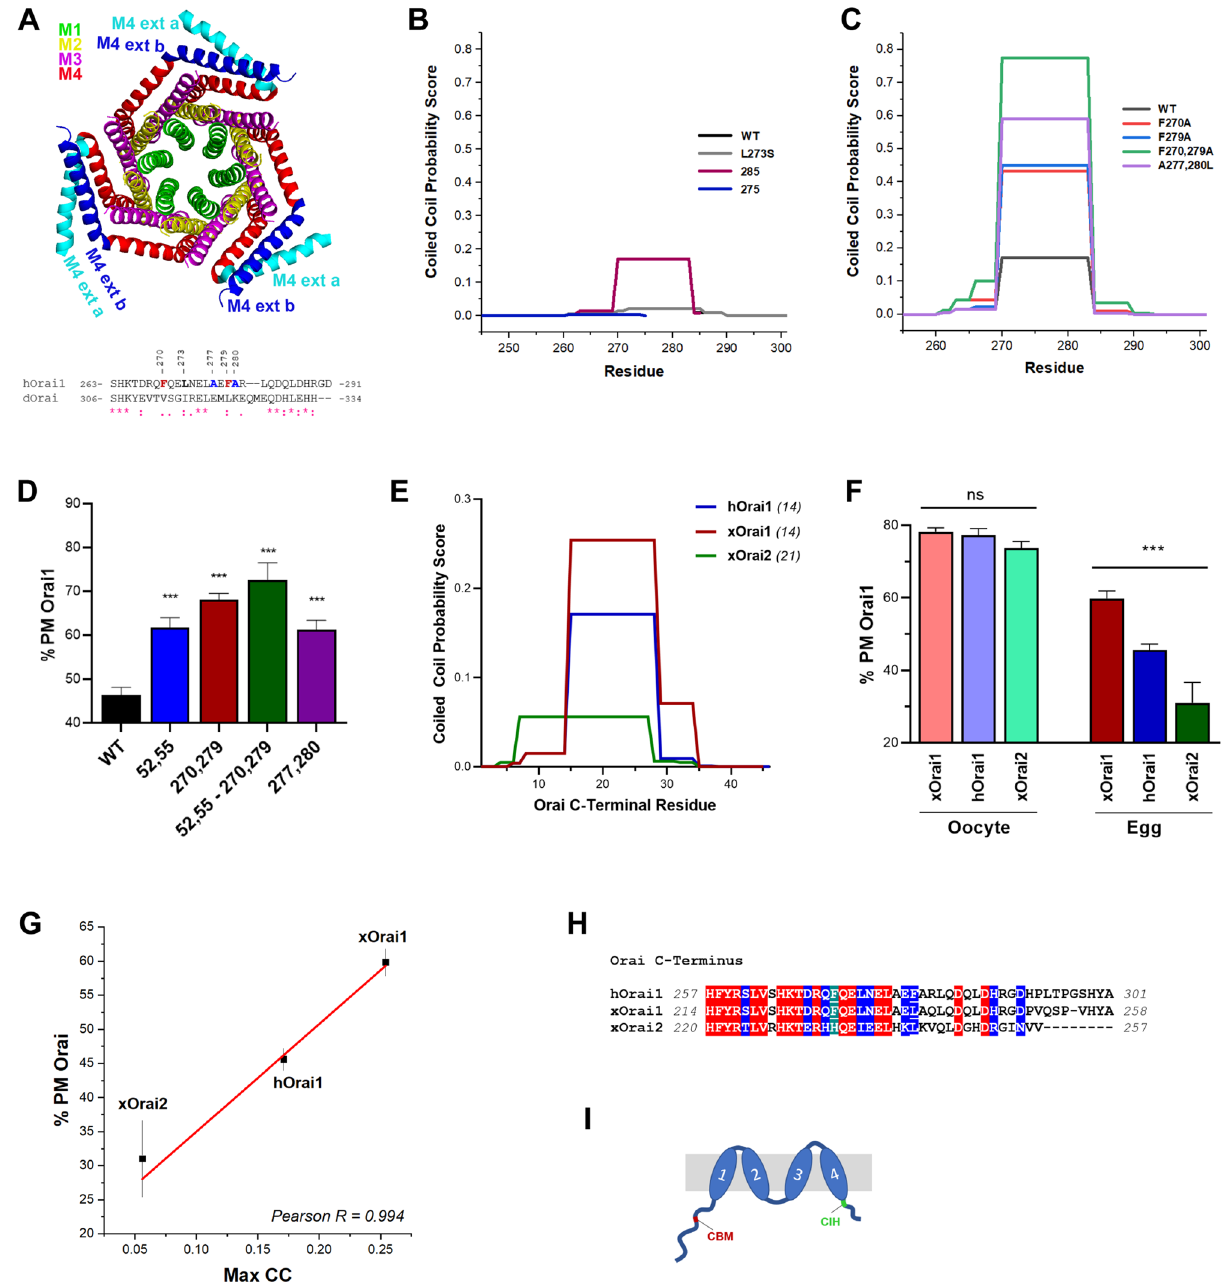
Figure 4. C-terminal CC structure regulates Orai1 internalization. ( A ) Orai1 crystal structure in the closed conformation (4HKR) with the 4 transmembrane helices in the hexameric Orai1 channel color coded as indicated. The M4 helical extensions that form the CC from adjacent subunits are shown in dark and light blue. CC sequence alignment between human and Drosophila Orai1 is also shown. ( B , C ) CC predictions using the COILS algorithm with a window of 14 residues 41 . ( D ) Percent PM Orai1 for the different mutants as indicated (Mean ± SEM, n = 13–26 eggs from 4 donor females). *** (p < 0.001), one way ANOVA. ( E ) CC predictions for the different Orai isoforms using the COILS algorithm. In this case the window that gave the highest CC probability is shown and is indicated in italics in parentheses. Human Orai1 (hOrai1, Q96D31), Xenopus Orai1 (xOrai1, Q5EAU0), and Xenopus Orai2 (xOrai2, Q6NZI6). ( F ) Percent Orai at the PM in both oocytes and eggs for the different clones as in panel (E). Mean ± SEM, n = 9–27 eggs from 3 donor females. *** (p < 0.001), ns (not significant), one way ANOVA. ( G ) Plot of percent Orai at the PM as a function of maximal CC probability for the three Orai isoforms. ( H ) Sequence alignment of the C-termini of hOrai1, xOrai1 and xOrai2. ( I ) Cartoon topology of Orai1 showing the CBM domain in the N-terminal cytosolic region and cytoplasmic internalization handle domain (CIH) in the Orai